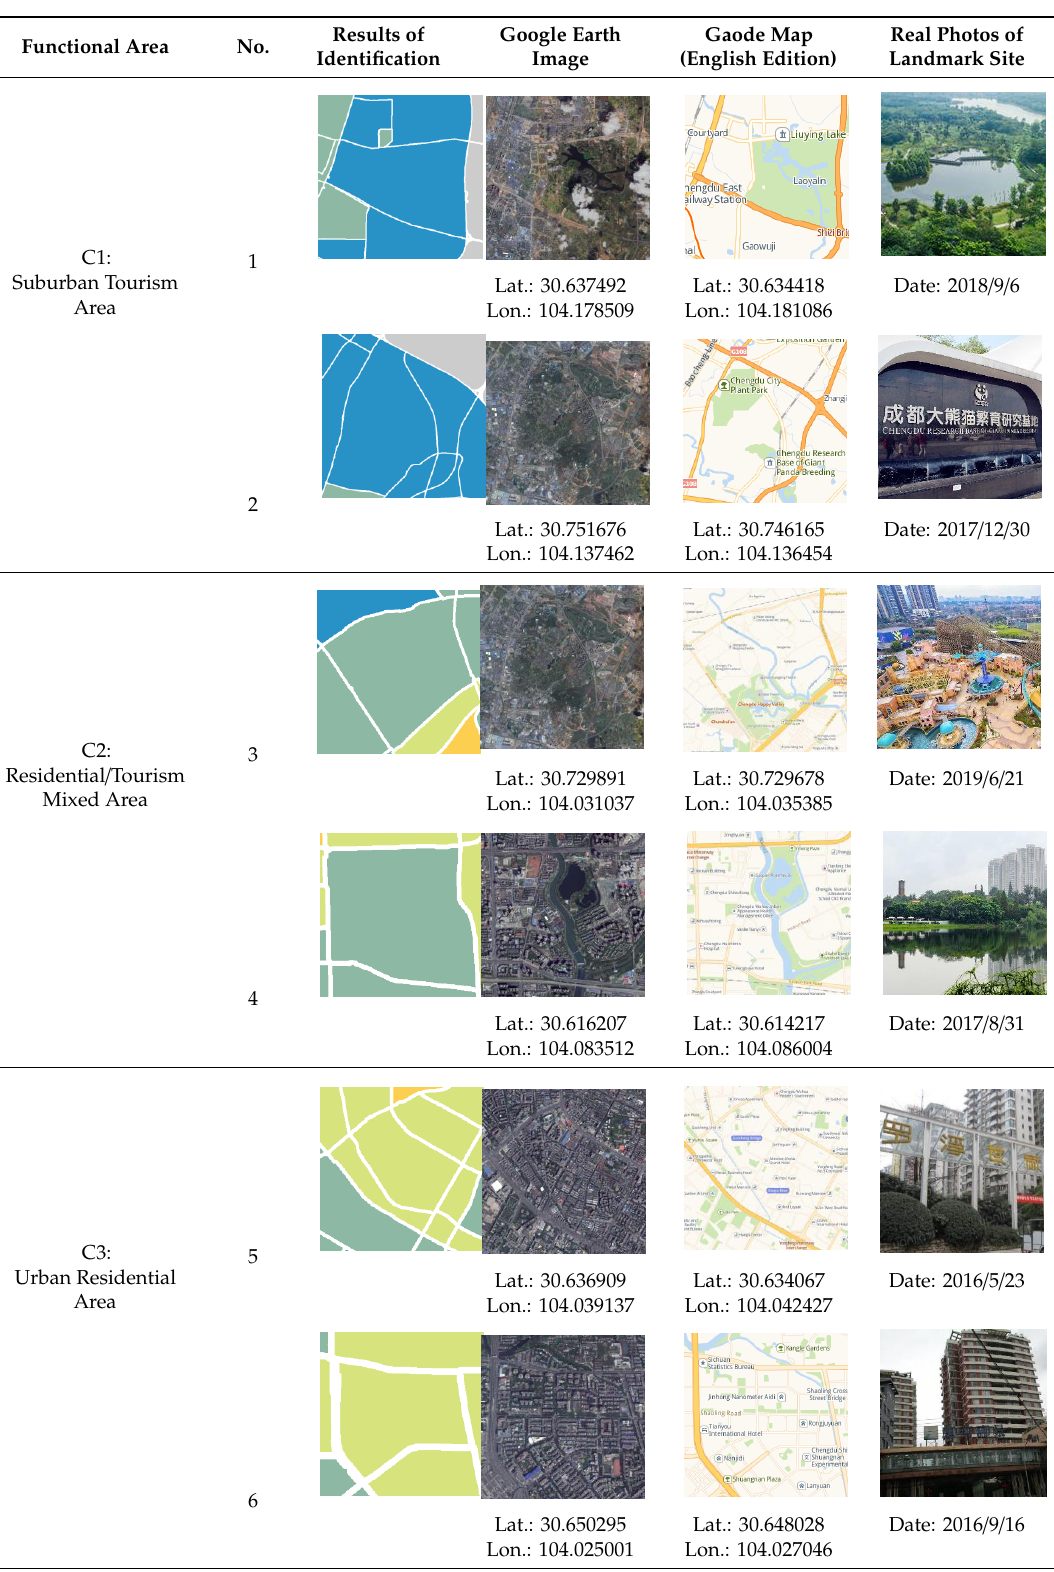
Table 2. Comparison and evaluation of functional area identification results. Functio nal Area